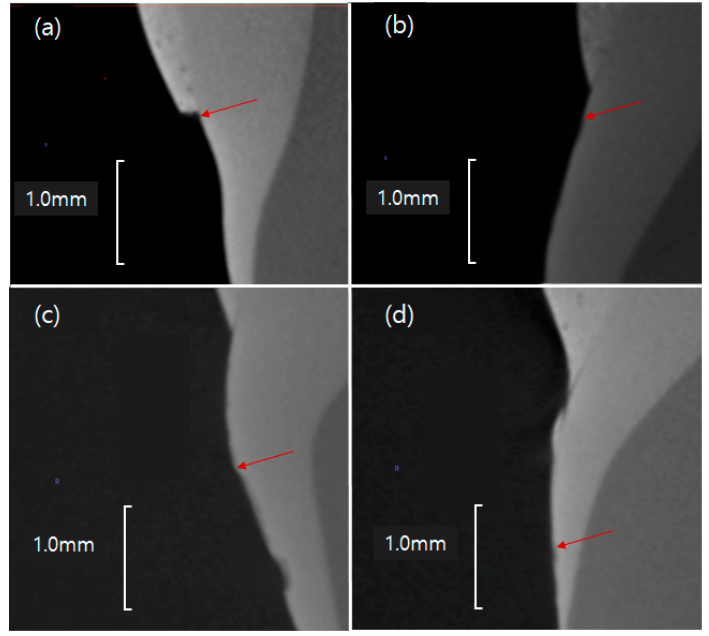
Figure 13. Remineralization points (red arrows) of the GaMBN-containing resins determined by micro-CT: ( a ) GaMBN0, ( b ) GaMB1, ( c ) GaMBN3, and ( d ) GaMBN5.